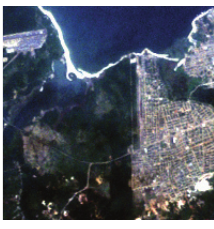
Figure 11: Landsat 5-TM calibrated image extract.